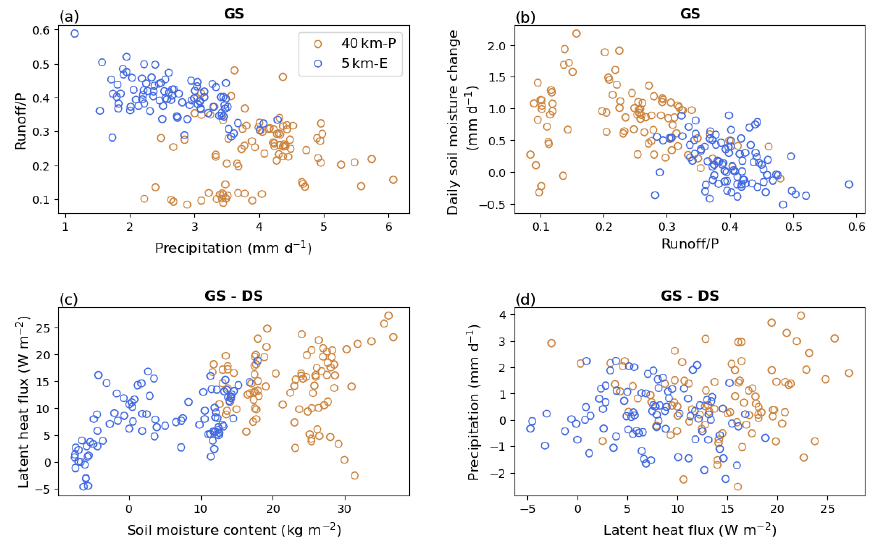
Figure 10. Relationship between different variables in the GS simulation (a, b) and the difference between the GS and the DS simulation (c, d) for the 5km-E simulations (blue circles) and the 40km-P simulations (orange circles). Each circle indicates 1d of the JAS season averaged over the WA domain outlined in Fig. 1. The panels show the following relationships: (a) the ratio between runoff and precipitation rate as a function of precipitation rate, (b) the daily change in soil moisture (within the six uppermost soil layers reaching up to a depth of 3.42m) as a function of the runoff–precipitation ratio, (c) the difference in latent heat flux as a function of the difference in total soil moisture content (again within the six uppermost soil layers reaching up to a depth of 3.42m), and (d) the difference in the precipitation rate as a function of the difference of latent heat